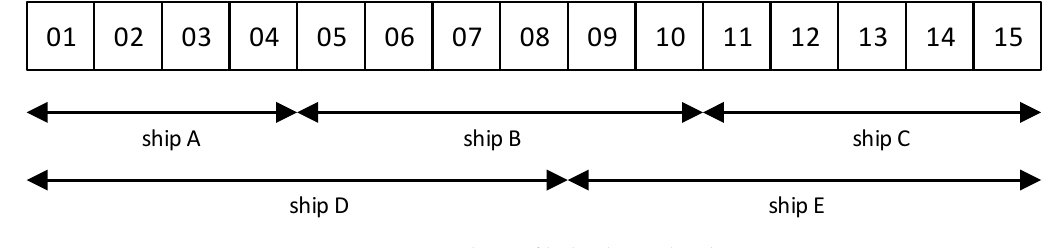
Figure 2. Marking of hybrid-type berths.